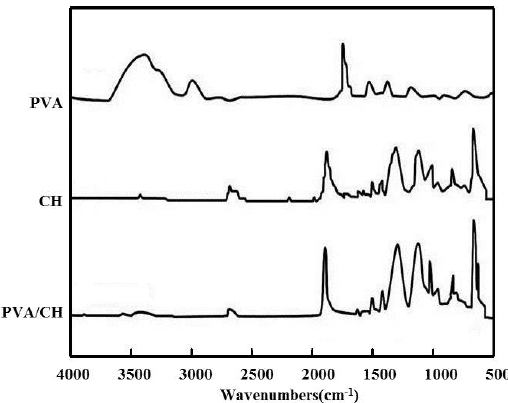
Figure 2. Attenuated total reflectance–Fourier transform infrared (ATR–FTIR) spectra of PVA, CH, and PVA/CH-2.5 films.